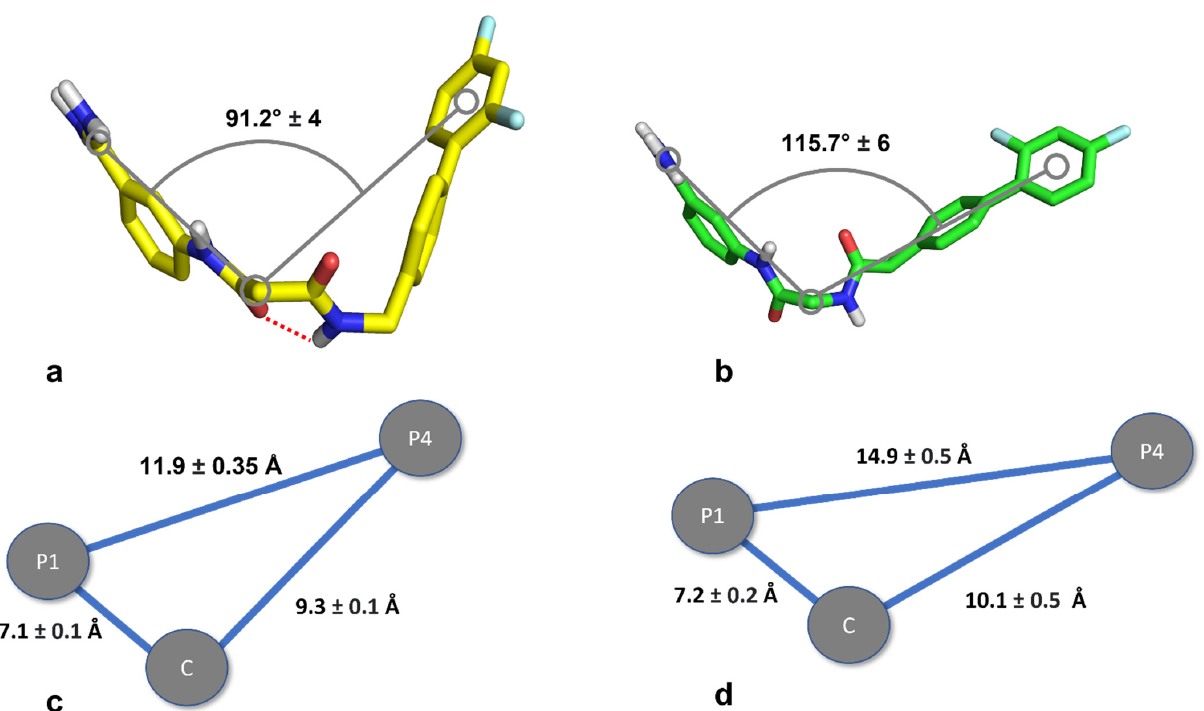
Figure 3. Panels ( a , b ) show the best conformer of 19h and 4c depicted as yellow and green sticks, respectively. The intramolecular HB is shown as dashed red lines. Joined by gray lines, the three gray circles indicate the anchoring point of the amidine group (P1), the center of malonamide/glycinamide bridge (C), and the centroid of the terminal phenyl of the P4 group. Panels ( c , d ) report the distances and the standard deviation among P1 ‐ C ‐ P4 for both compounds.